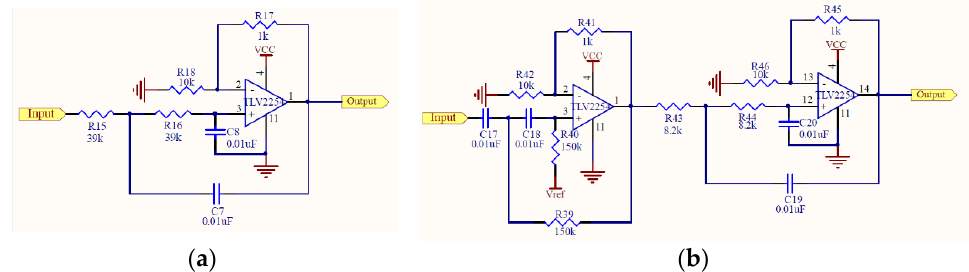
Figure 5. ( a ) Filter circuit for heart sounds and ( b ) filter circuit for lung sounds.